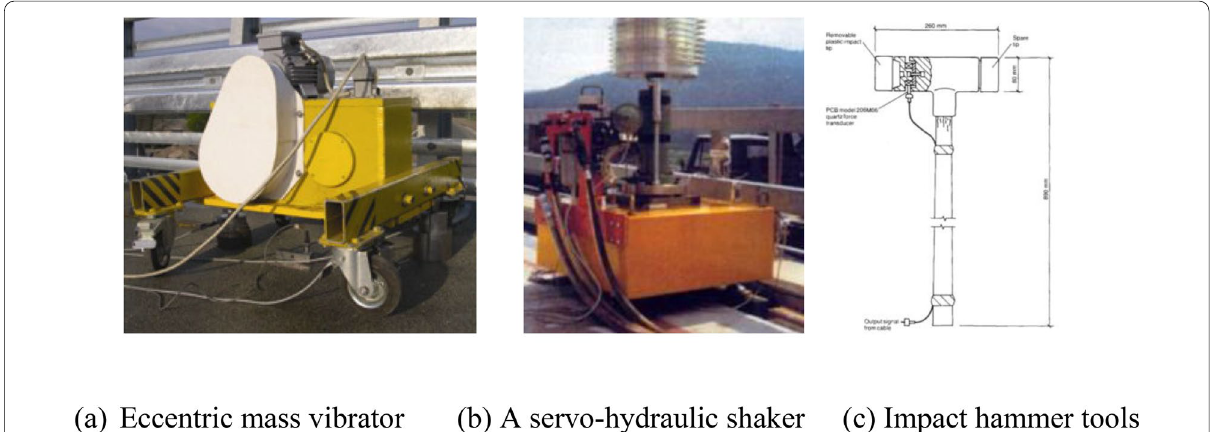
Fig. 3 Forced vibration test excitation technique (Zwolski & Bień,